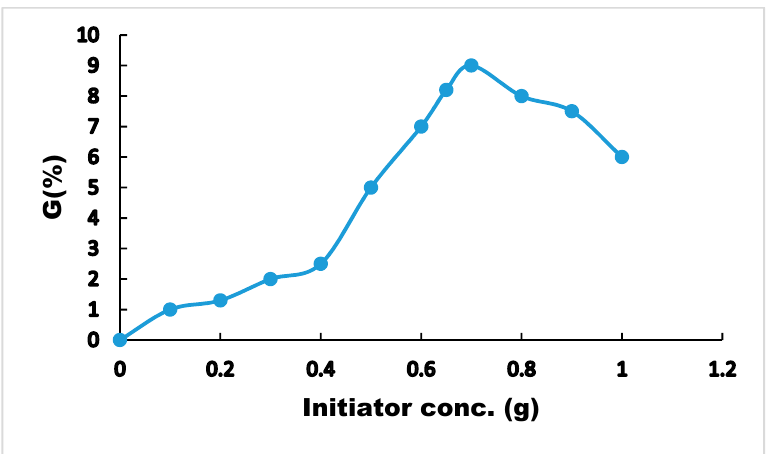
Figure 3. Optimum initiator concentration for microwave synthesis of the Interpenetrating Network Biohar Composite (IPNCB).